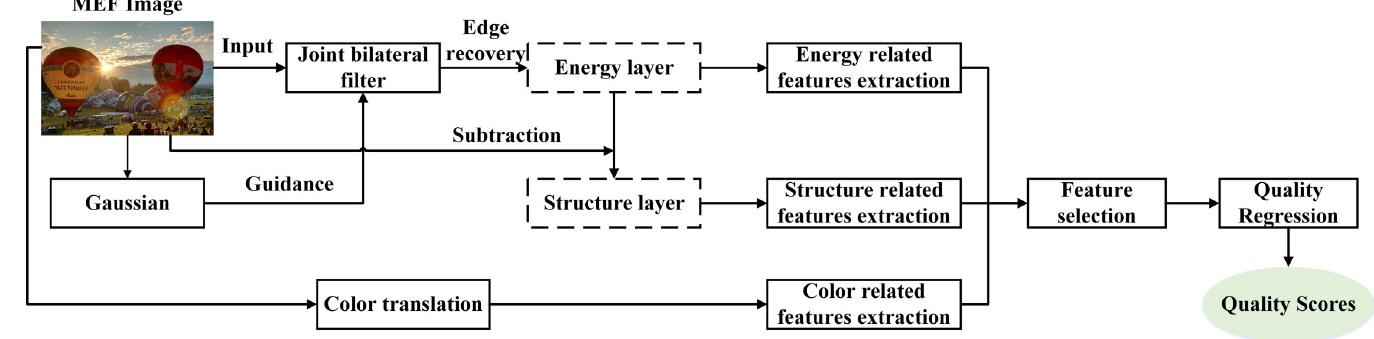
Fig 1. The framework of the proposed